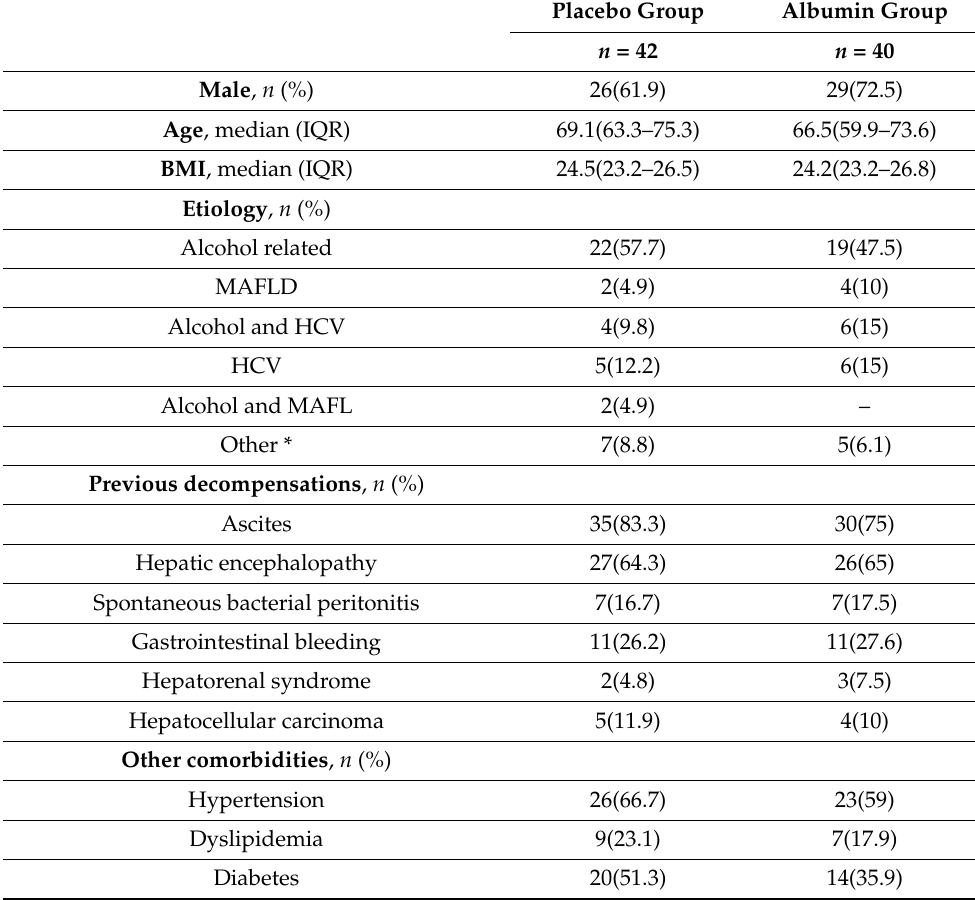
Figure 1. Study flow chart. * Patients could have more than one exclusion criteria. In 20 patients, the exclusion criteria were not recorded. Table 1. Baseline characteristics of the BETA trial by treatment